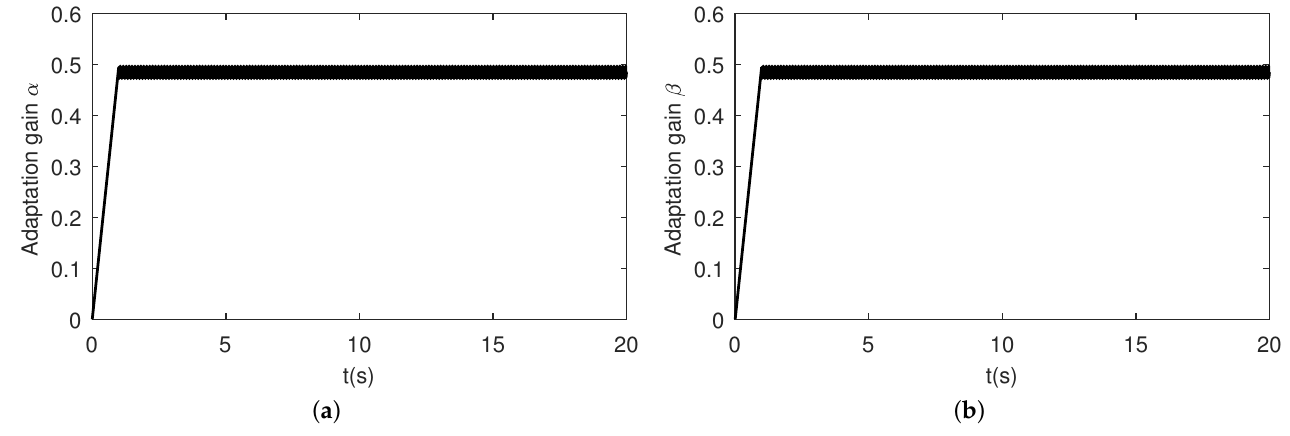
Figure 7. Adaptation gains with disturbances: ( a ) α . ( b ) β .